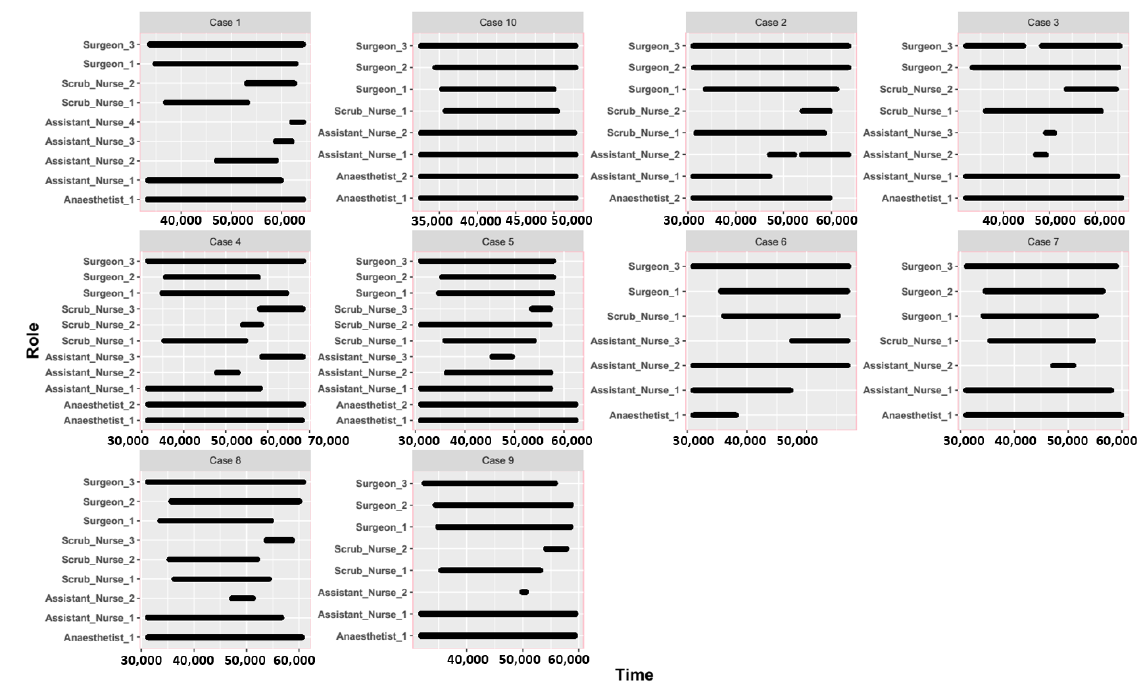
Figure 2. Temporal patterns of the surgical staff during surgery.